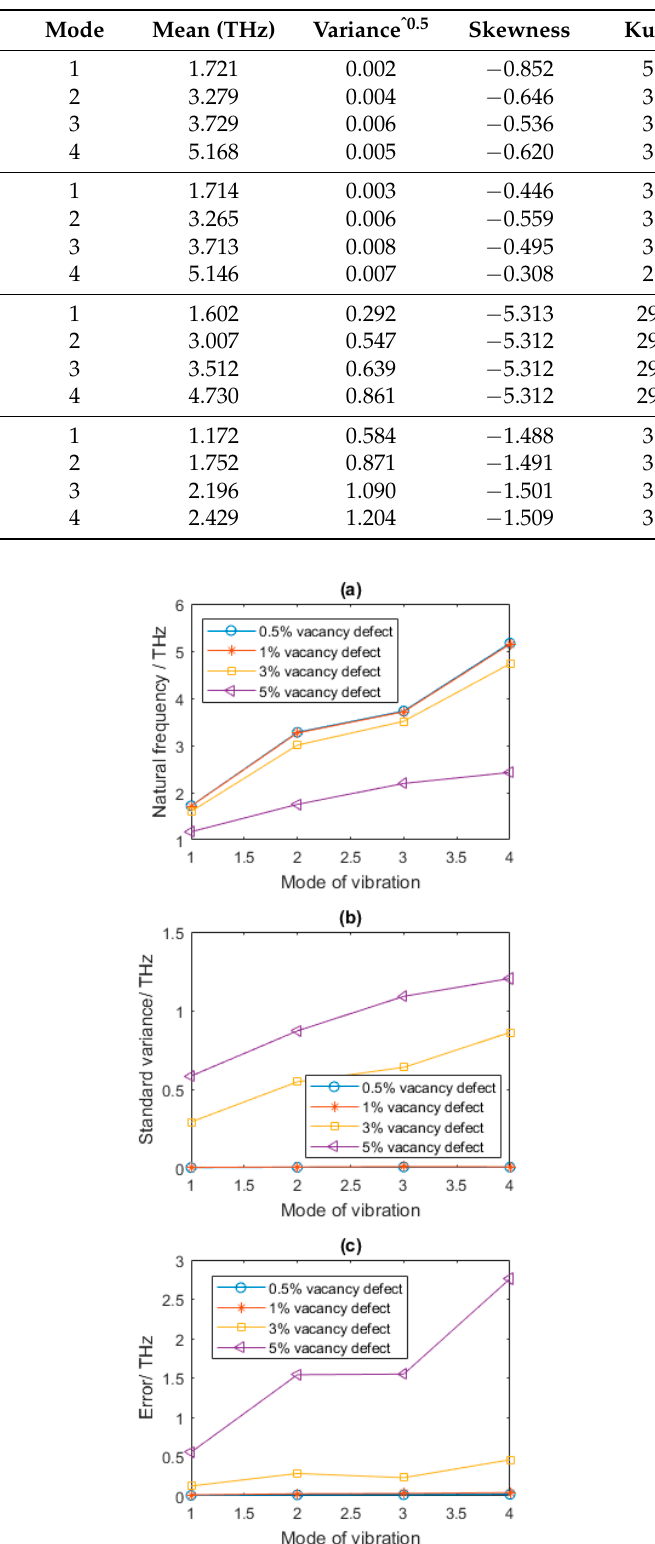
Table 2. Statistical results of natural frequencies for Monte Carlo based finite element model